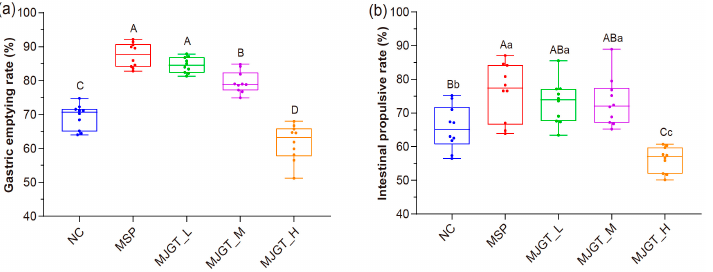
Figure 1. Effect of different concentrations of MJGT hydro extracts on gastric emptying rate ( a ) and intestinal propulsive rate ( b ) in vivo. n = 10 rats for each group. Capital and lowercase letters above the bars indicate the difference significance at 0.01 or 0.05 level, respectively.